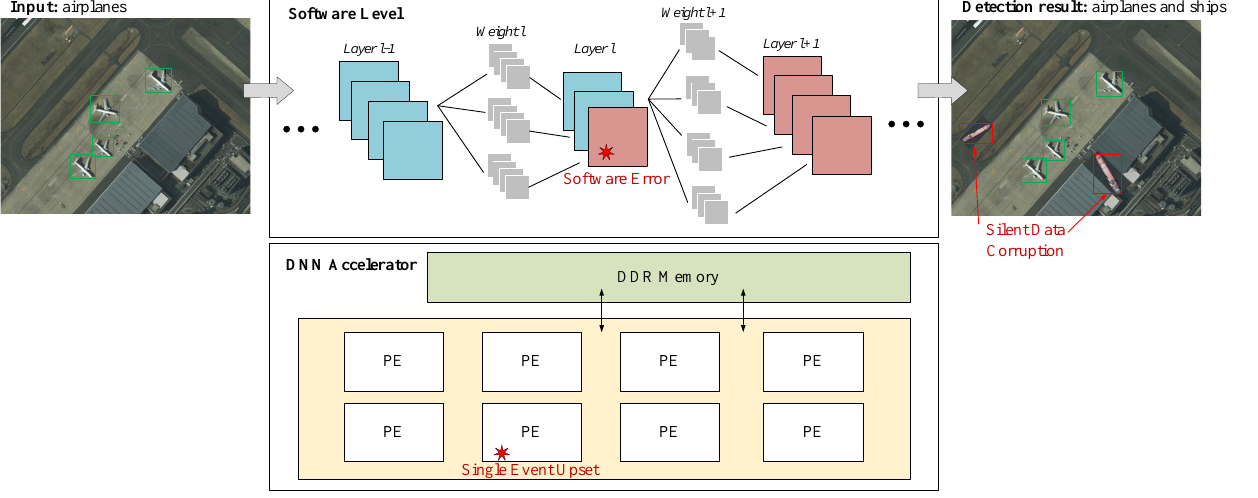
Figure 1. Demonstration of an on-orbit object detection anomaly caused by a transient fault. The SEU flips a register bit in the processing element, which causes a software error in the feature map. This error eventually leads to a corrupted object detection